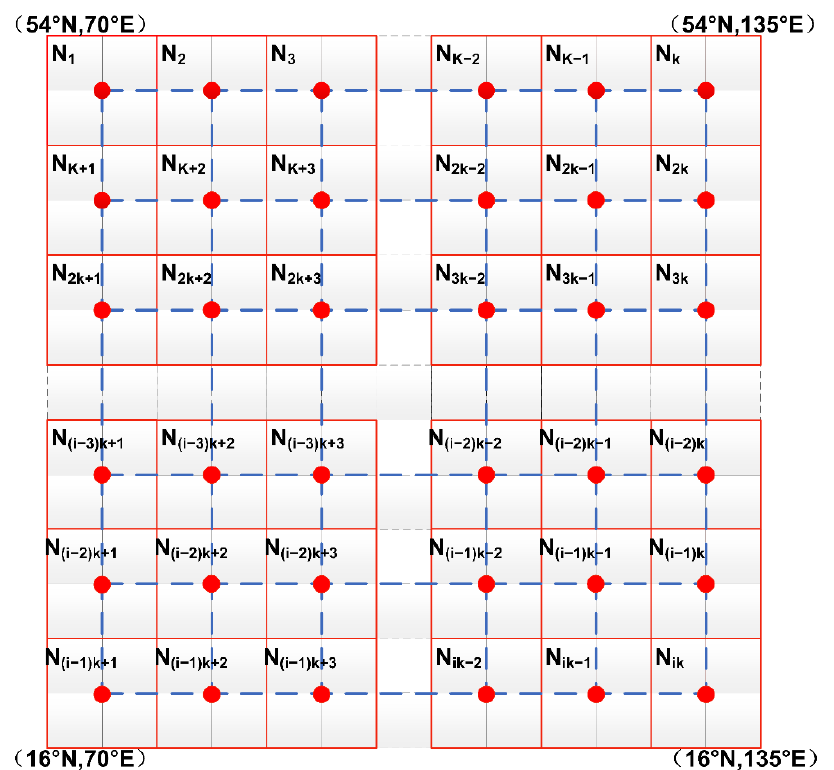
Figure 6. Realization process of the sliding window algorithm over China. The red rectangles denote the size of the sliding windows, and the red dots denote the center point of each window. The new grid over China consists of red dots and blue dashed lines.